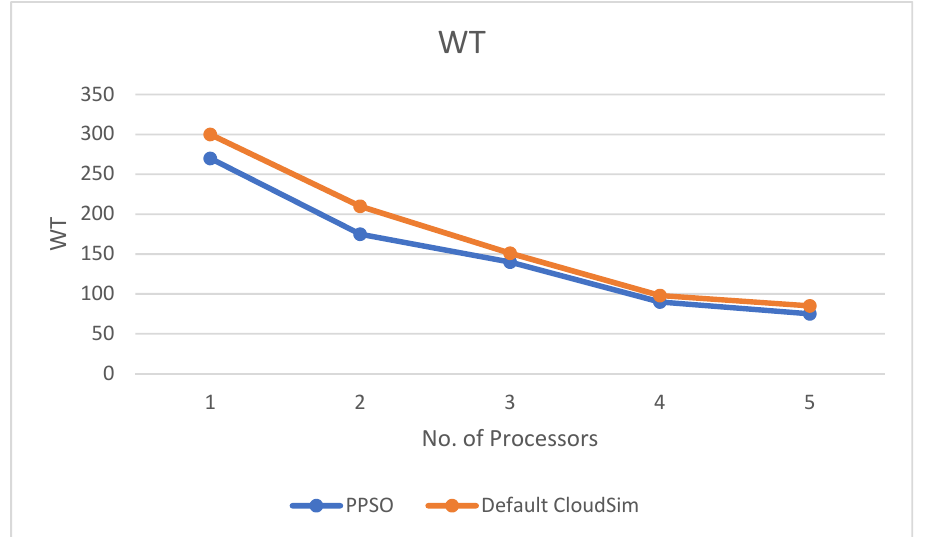
Figure 5. The relation between TT and number of processors.